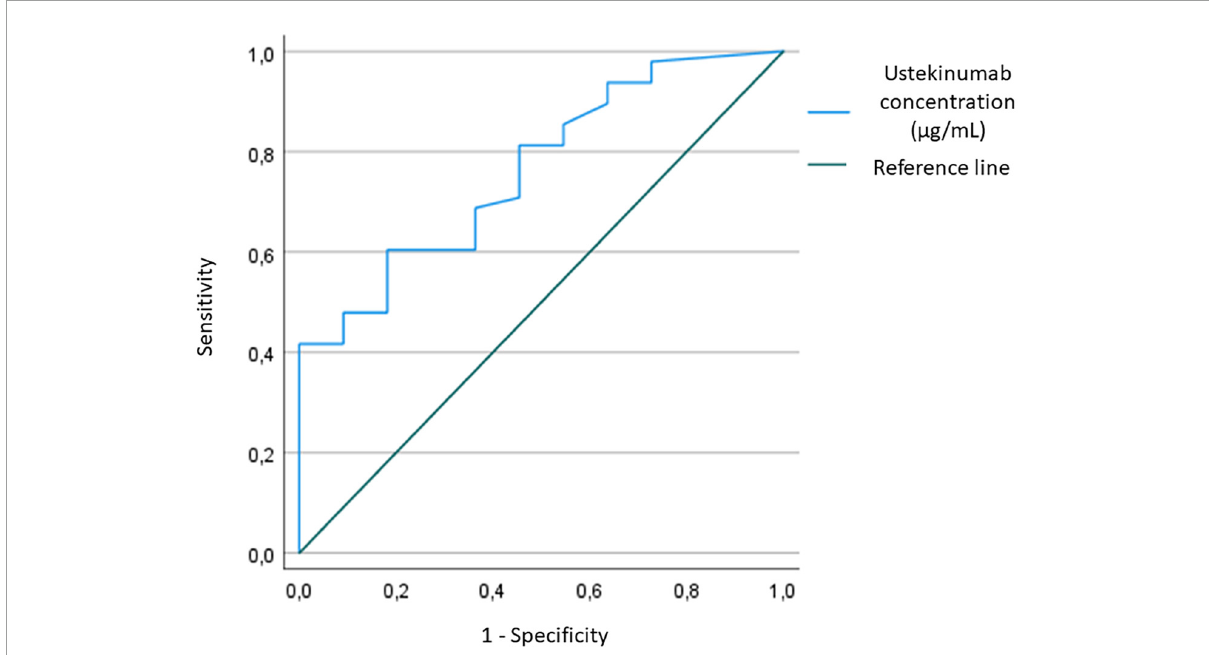
FIGURE2 Receiver-operator characteristic (ROC) curve for sensitivity and specificity to determine ustekinumab concentration cut-off to achieve optimal